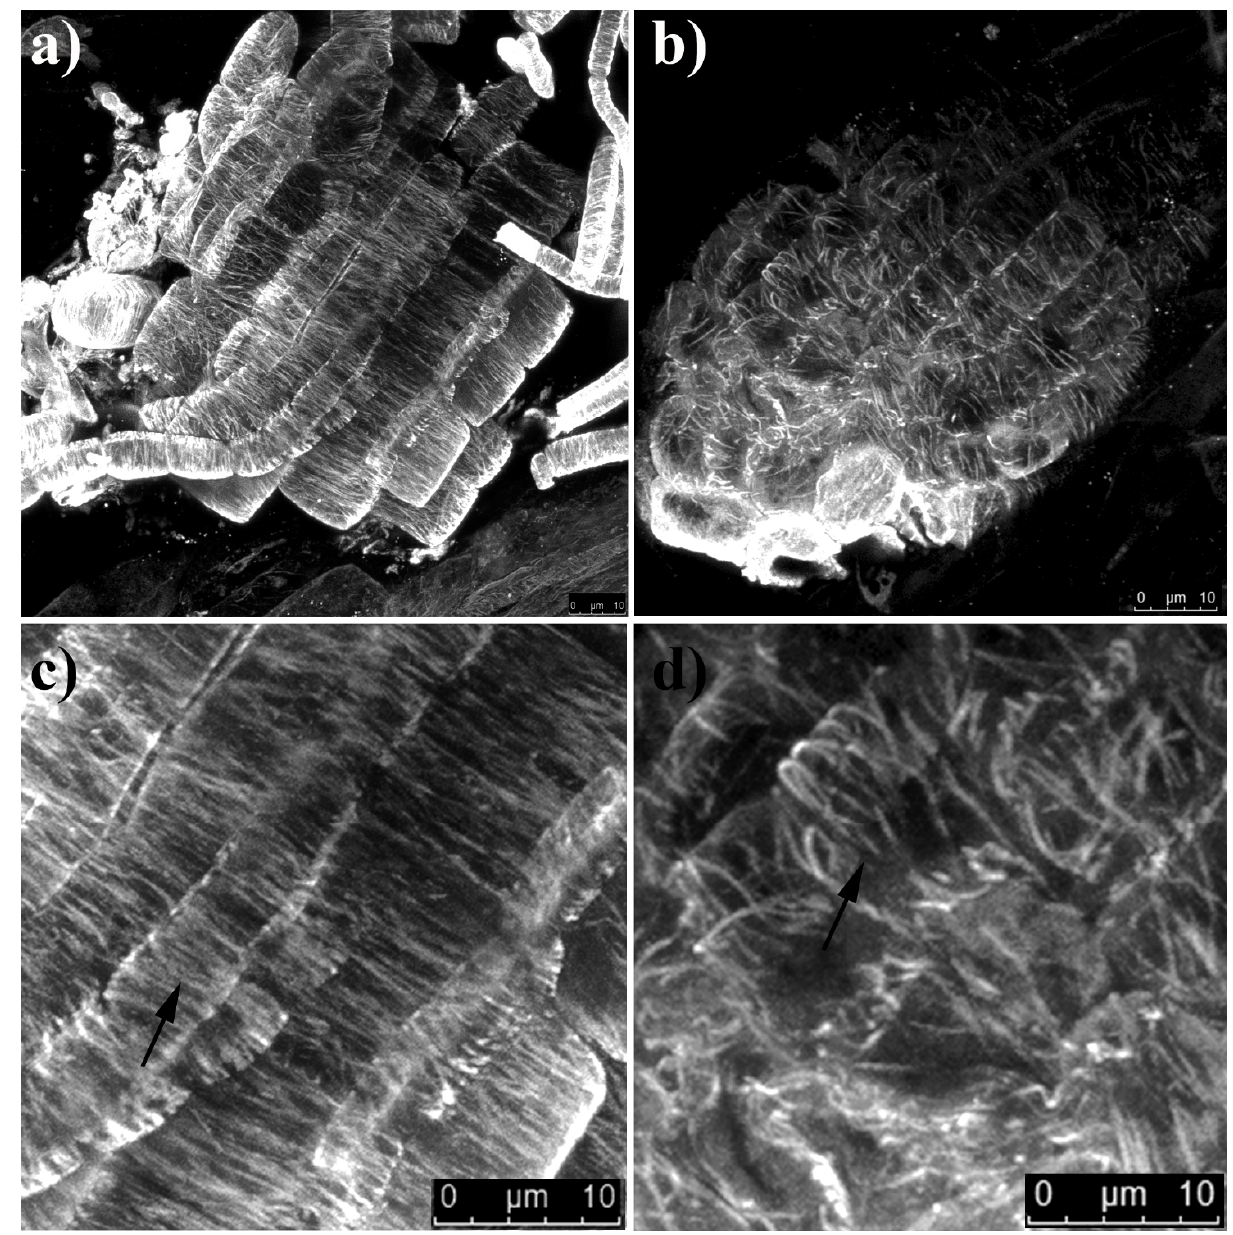
Figure 3. Microtubule immunostaining of 4 days old Arabidopsis roots treated for 7 days with coumarin. ( a ) Control cells (0 µM); ( b ) coumarin-treated cells (100 µM); ( c , d ) zoomed-in view of a specific area of the images of ( a , b ), respectively, to make coumarin-induced microtubule alterations clearly visible. Black arrows (in ( c , d )) indicate parallel, dense, and well-organized microtubules in the control cells and disorganized and lax microtubules in coumarin-treated cells. Scale bars (images a , b ): 10 µm. N = 20.